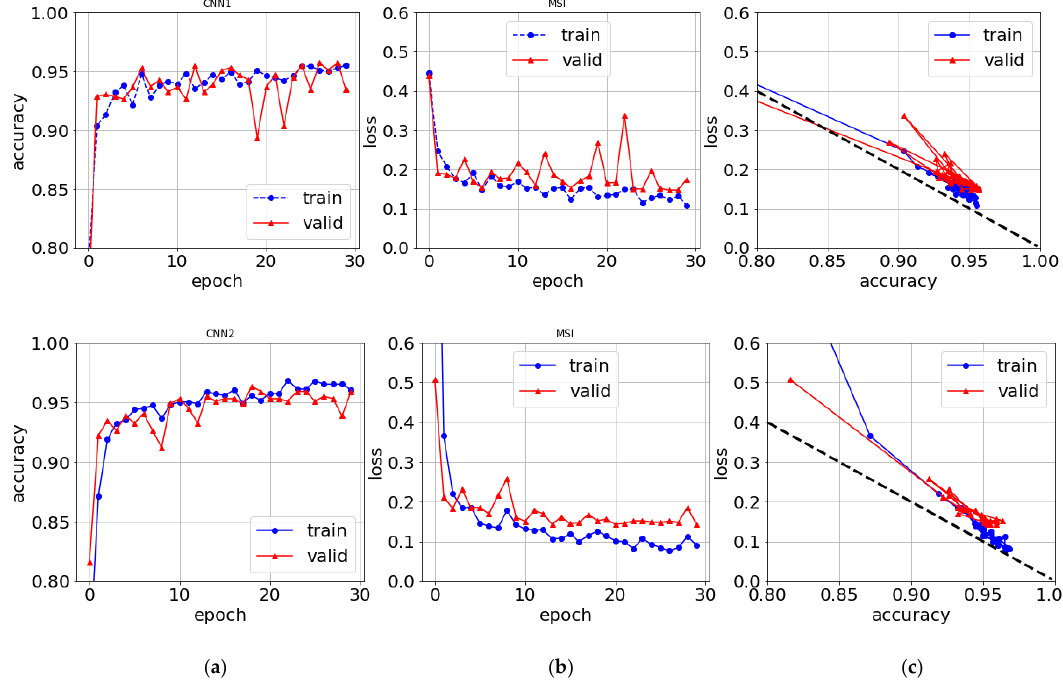
Figure 10. As Figure 9 but for the MSI dataset.